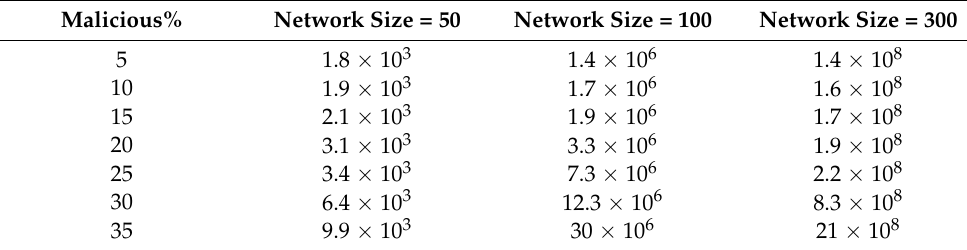
Table 2. Total AEC ( µ J) in the network.